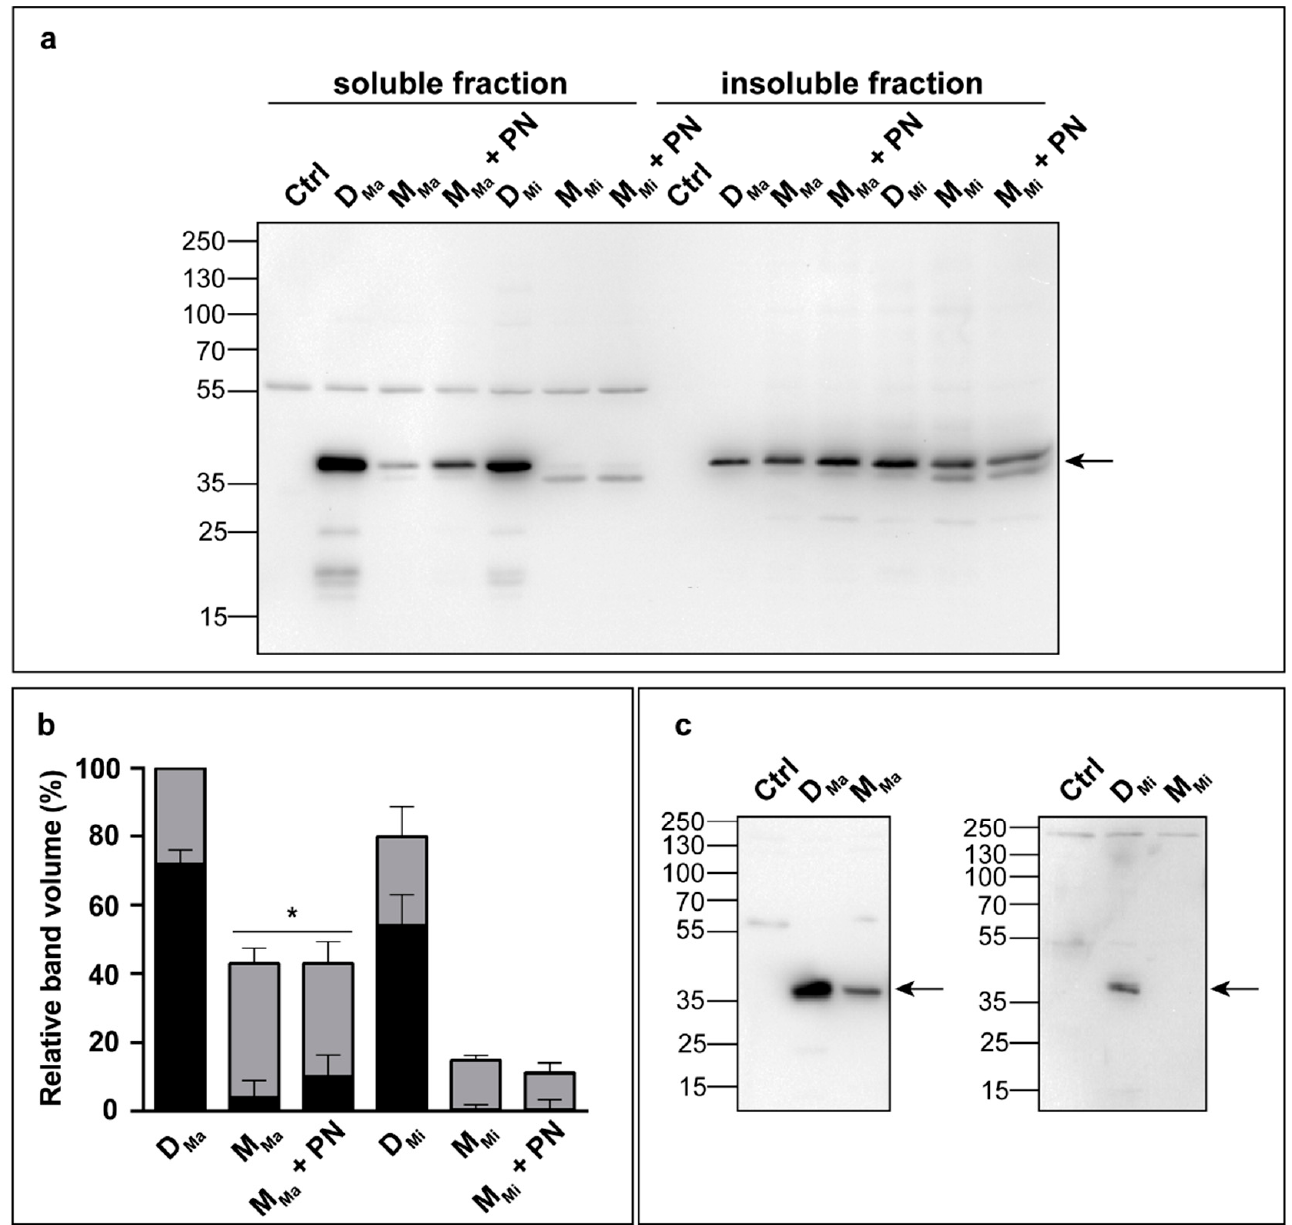
Figure 1. Analysis of AGT protein levels in the absence or presence of pyroxidine (PN). ( a ) Chinese hamster ovary cells stably expressing glycolate oxidase (CHO-GO) untransfected (Ctrl) or expressing the indicated AGT species, treated or not with PN (10 µM) for 7 days, were lysed, and 5 (D Ma /M Ma ) or 10 (D Mi /M Mi ) µg of the soluble and insoluble (as indicated) fractions were analyzed by Western blot with an anti-AGT antibody from rabbit. ( b ) Immunoblot band volumes are represented as histograms and expressed as percentage of the protein present in the soluble (black) and insoluble (grey) fractions of the cell lysate relative to D Ma . Data are expressed as mean ± SEM (n = 4). *, p < 0.05 ( c ) The soluble fraction of each lysate was analyzed by Western blot using antibodies that specifically recognize the AGT N-terminus (antiPro11 for D Ma and M Ma ; antiLeu11 for D Mi and M Mi ). The arrow in panels ( a , c ) indicates the band relative to AGT.